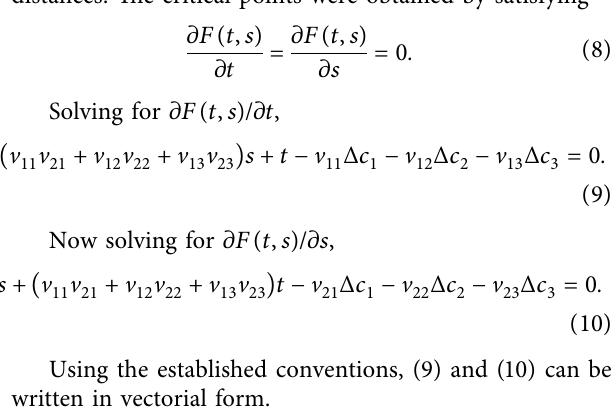
Table 4: Growth rate estimated by orthogonal least squares by altitudinal